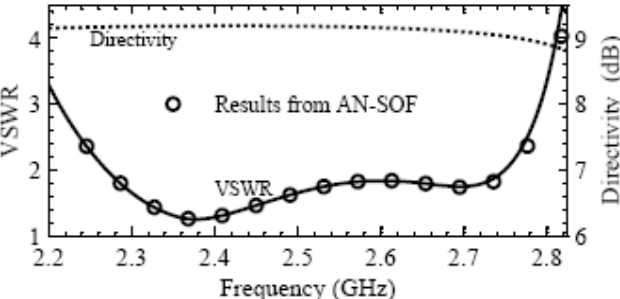
Figure 12: Directivity and VSWR for the 3-elements CCLA backed with ground plane with b